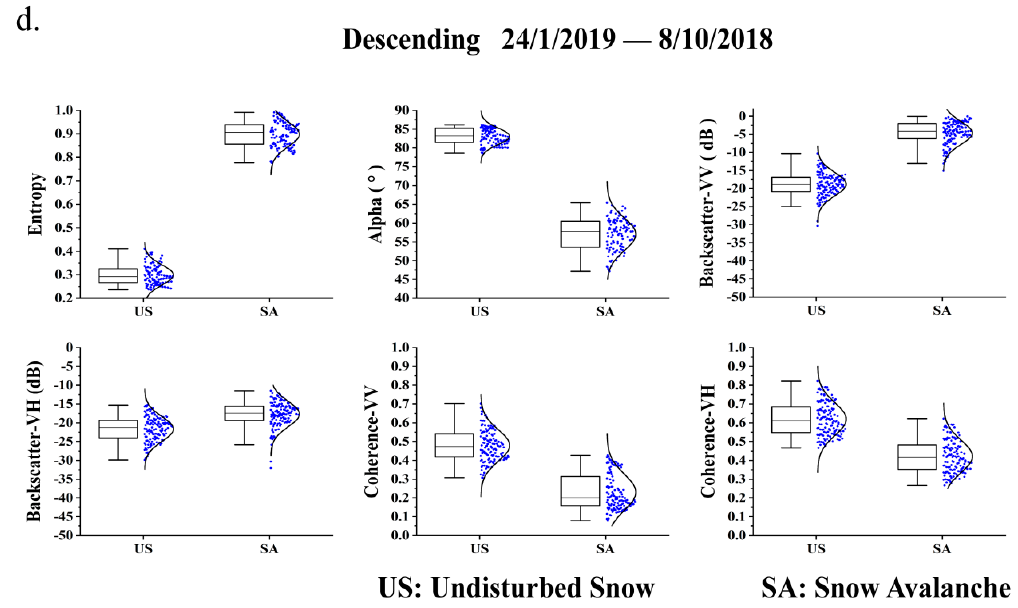
Figure 3. Scattering and interference characteristics of ( a , b ) avalanche and ( c , d ) boxplots.